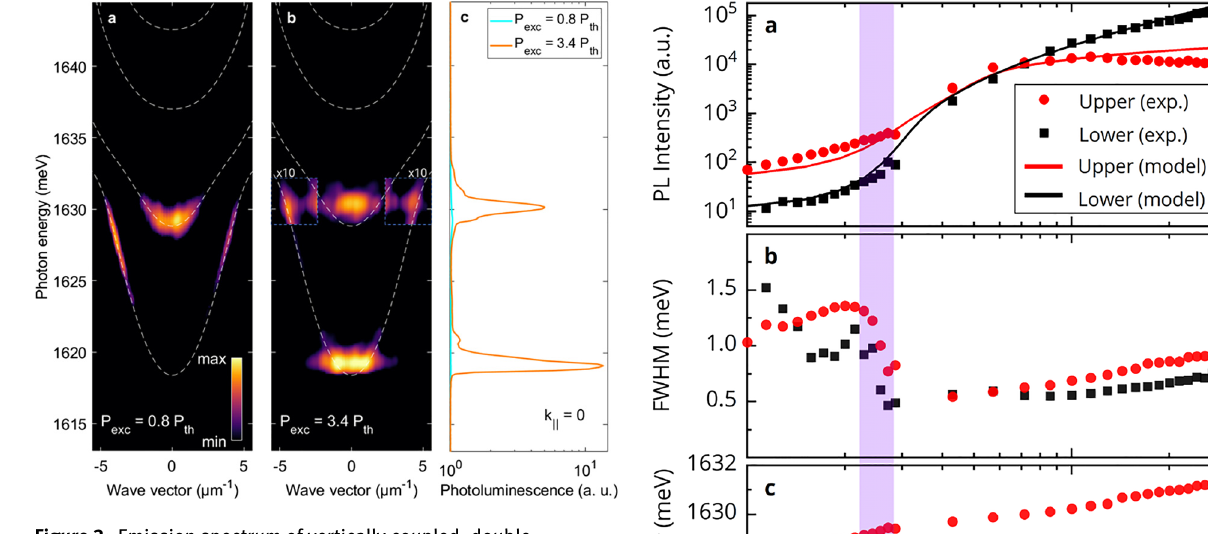
Figure 3: Emission spectrum of vertically coupled, double microcavities resolved in in-plane photon momentum below = 0.8 P = 3.4 P ) and above ( P ) the excitation density ( P exc th exc th = 25 kW cm − 2 . corresponding to the polariton lasing threshold at P th White dashed lines represent calculated polariton levels. The indicated portion of the plot is multiplied by a factor of 10.